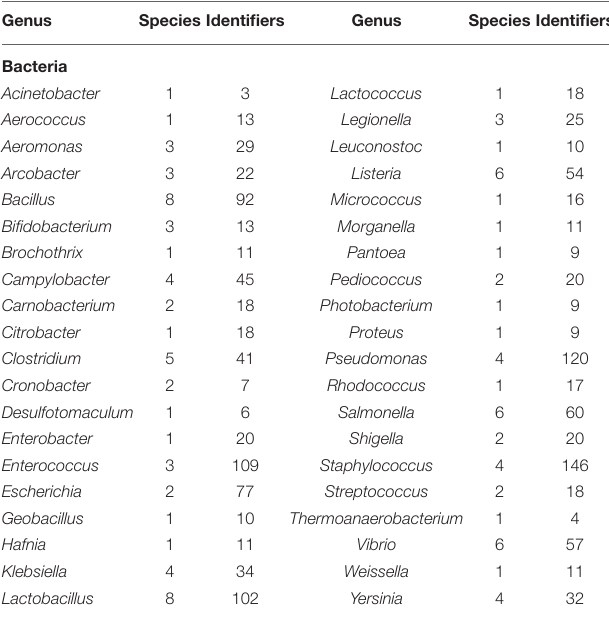
TABLE 2 | The number of bacterial species in the WDCM reference strain catalog that have identifier numbers for the reference strains (WDCM, 2019). Genus